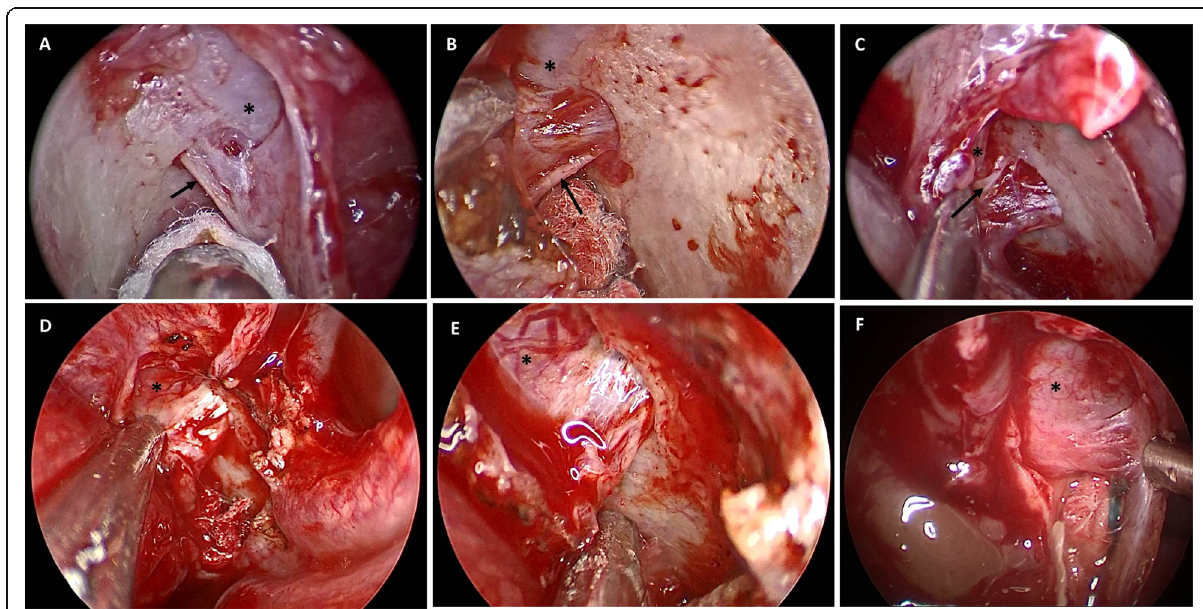
Fig. 3 a – f Intraoperative endoscopic pictures from both groups showing the variable relationship of SPA with the mucosa of the lower part of basal lamella (black star) and sphenopalatine nerve bundle (black arrow); it was separable from the main arterial trunk in the non-epistaxis group ( a – c ) and amalgamated, inseparable in epistaxis group ( d – f